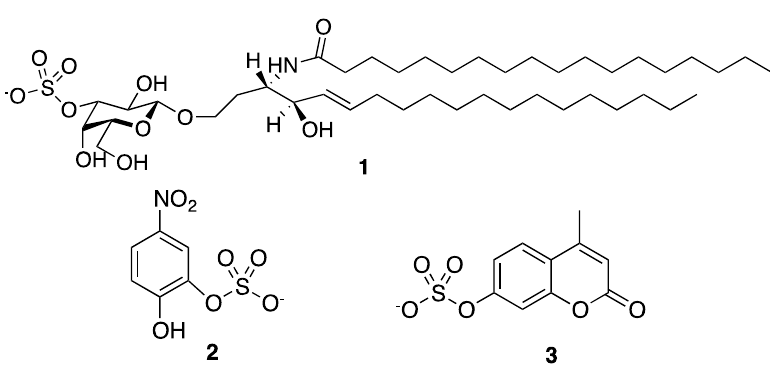
Figure 1. Natural and known phenolic substrates of